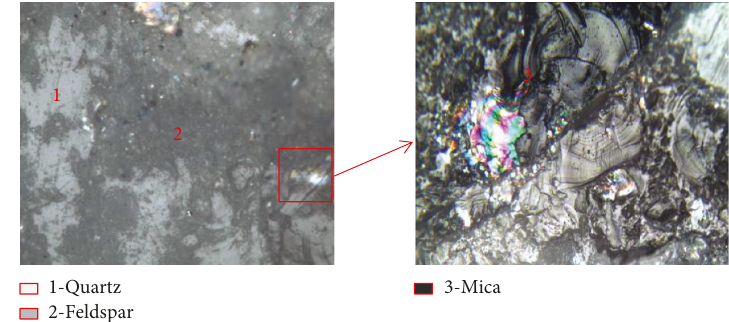
Figure 1: Microscopic structure of the mineral